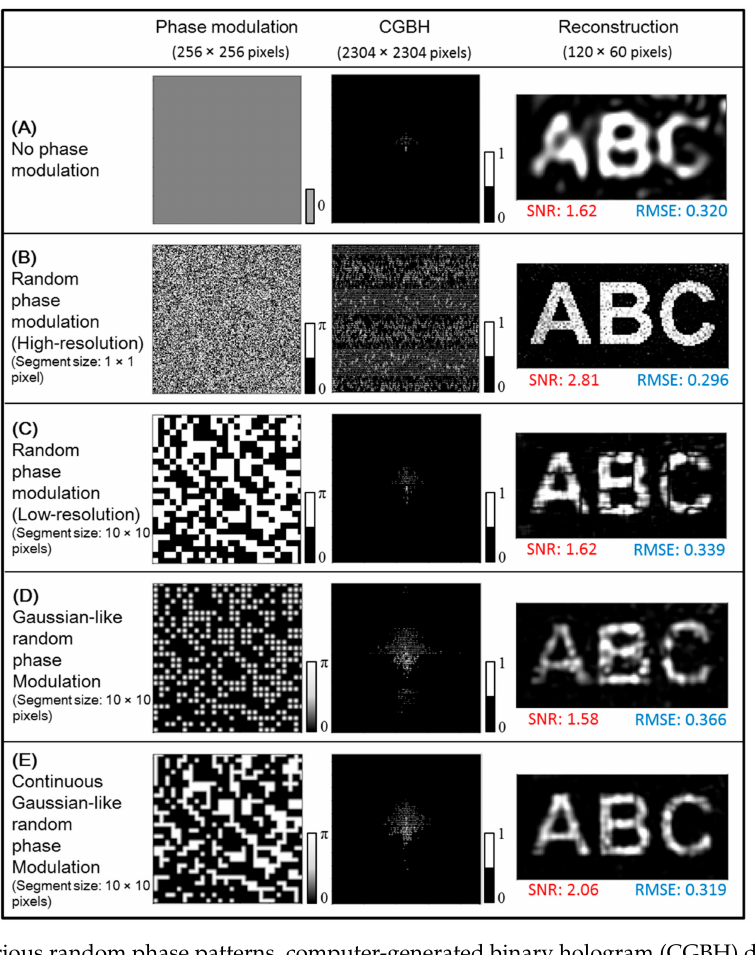
Figure 2. Various random phase patterns, computer-generated binary hologram (CGBH) distributions, and reconstruction results.